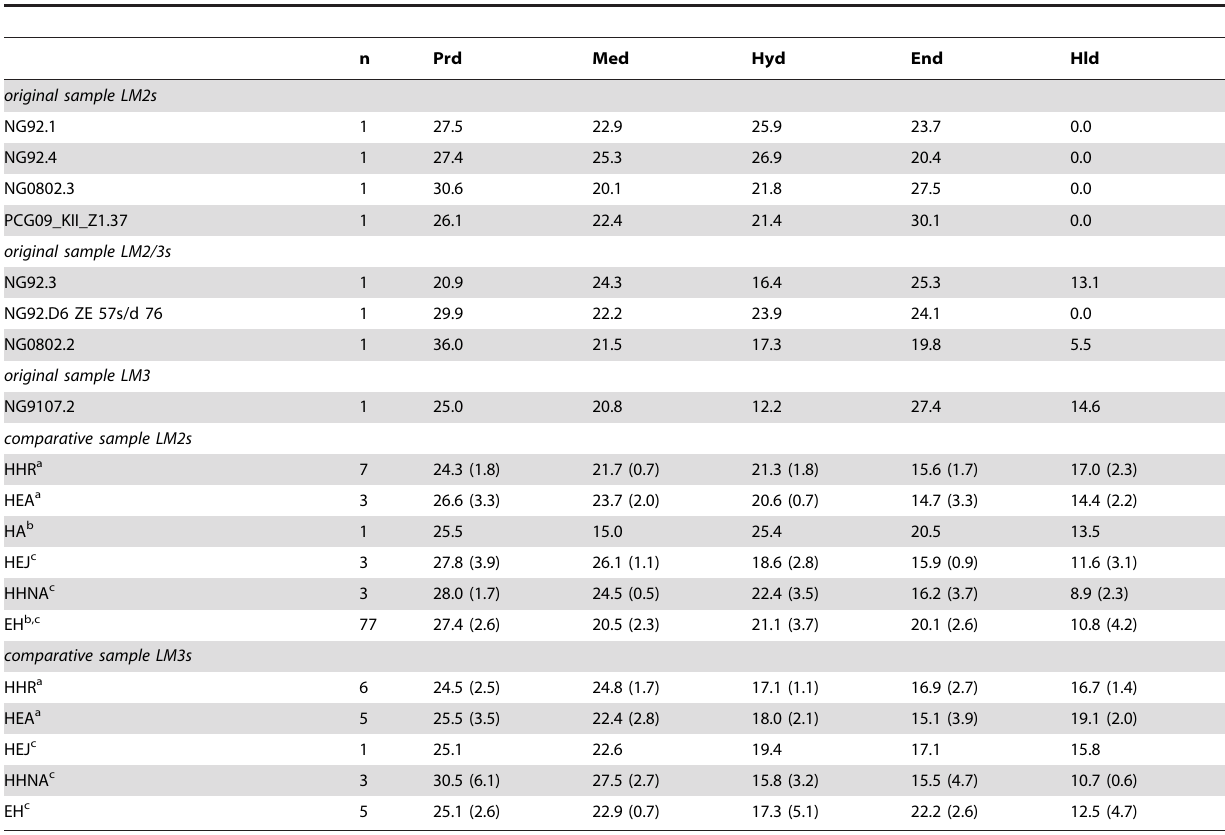
Table 4. Cusp area estimates of eight LM2 and LM3 crowns from the new Javanese fossil human dental sample compared to the figures from six extant and fossil human